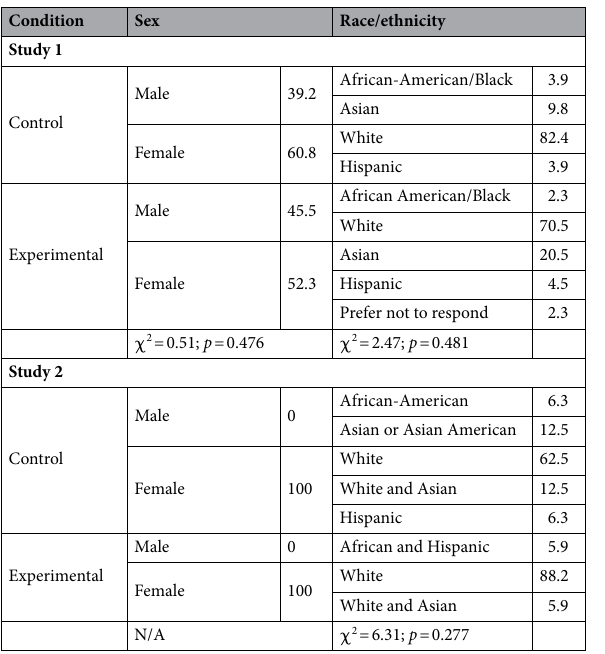
Table 1. Demographic information for participants in Study 1 and Study 2 in percentages. chi-square and p values indicate the magnitude of the differences in frequencies between the acute stress and control condition for each variable.